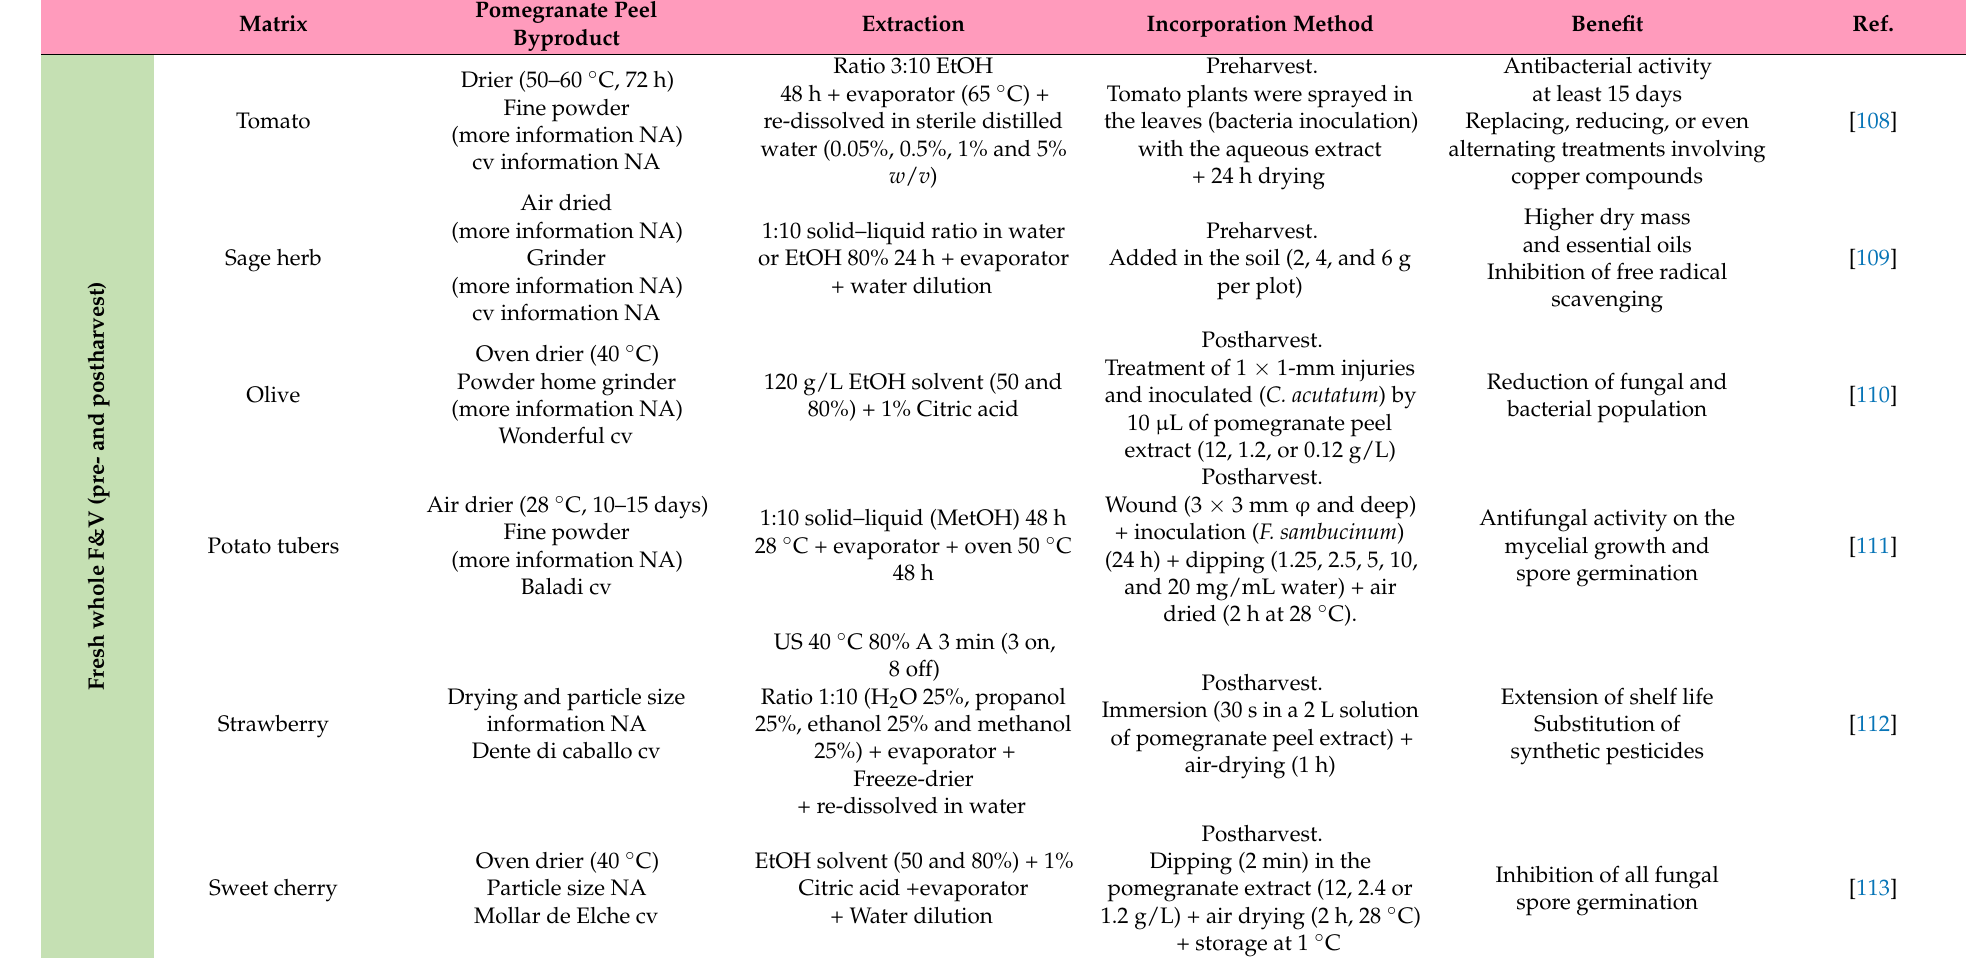
Table 5. Application of pomegranate peel in fresh fruit and vegetable, minimally processed fruit and vegetable, and